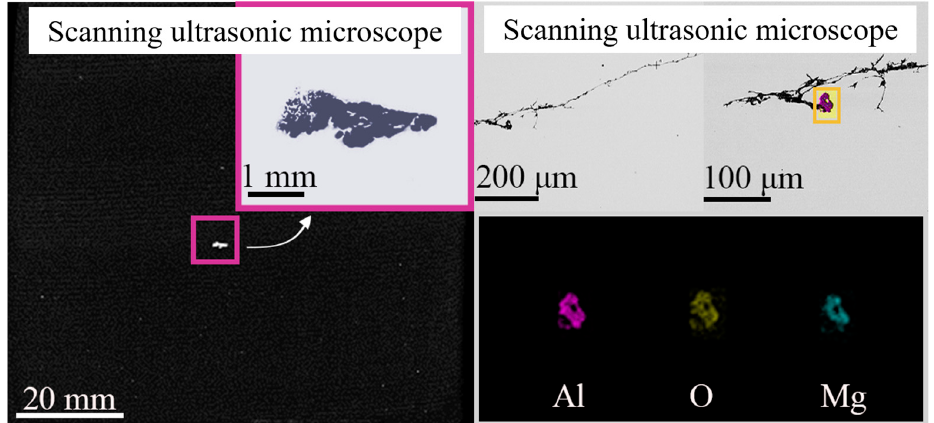
Figure 8. Electron microscope images and elements mapping after dissection of the maximum defect. The large inclusions on the scanning surface were statistically analyzed, and the number, types, and average particle size of inclusions were summarized, as shown in Figure 9. The number of inclusions of Al 2 O 3 -SiO 2 type is the largest, while the average particle size of the inclusions of Al 2 O 3 -CaO-MgO and Al 2 O 3 -MnS types is larger: both over 20 μ m.